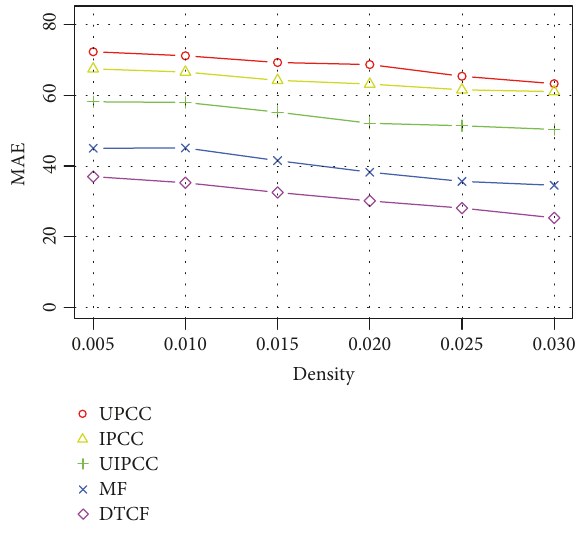
Figure 3: MAE with respect to